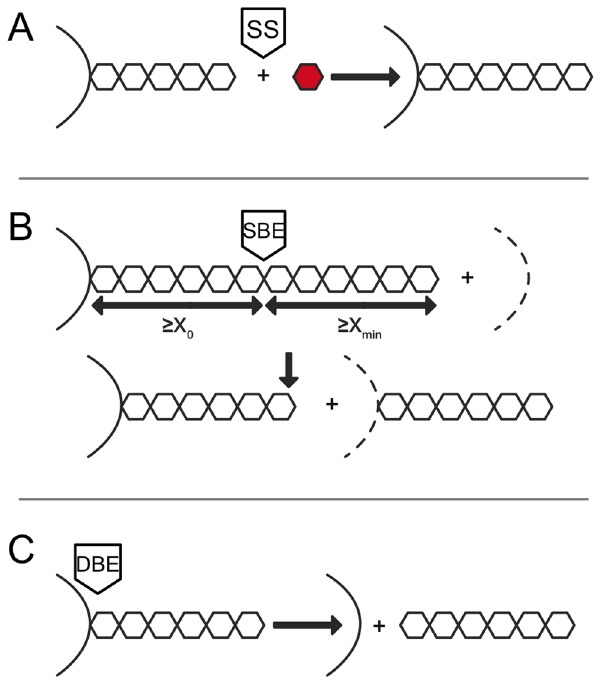
Figure 1. The mechanism of actions of three core enzymes in starch biosynthetic considered in the model. Starch synthases (SSs) transfer ADP-glucose (red hexagon) to the non-reducing end of a pre-existing a -(14)-linked glucan. Starch branching enzymes (SBEs) transfer the cleaved chain onto a random position–which may include the original branch–via an a -(16) link. The length of the transferred portion by SBEs has to be $ X min and that of the remaining stub must be $ X 0 . Debranching enzymes (DBEs) hydrolyze a -(16) linkages, thereby removing the whole chain. These enzymatic schemes are focused on the form of glucans in terms of the CLD rather than the actual products. Together, one of each of SS, SBE and DBE, regardless of the actual isoforms, make up an enzyme